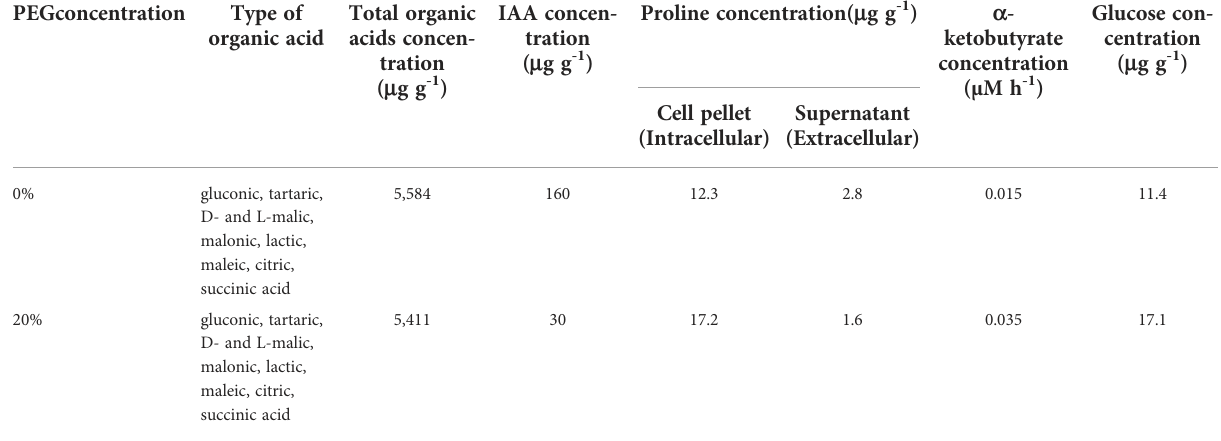
TABLE 1 Total concentrations of organic acids, indole acetic acid, proline, a -ketobutyrate (ACC deaminase determination), glucose (EPS determination) and type of organic acids produced by strain KKUT8-1 grown without PEG and with 20% PEG incubated at 40°C.